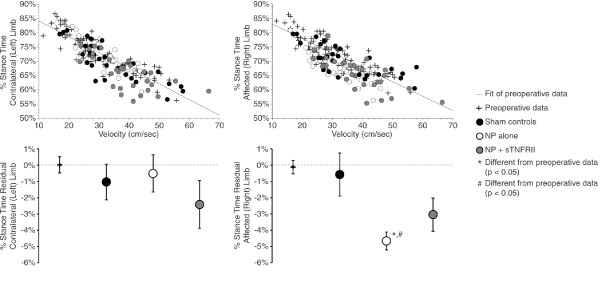
Affected and contralateral percentage stance time in rats with lumbar radiculopathy (five days post-operation). A significant correlation between percentage stance time and velocity is observed in walking rats (upper left and right); raw data with a linear fit of the pre-operative data are shown. As velocity increases, percentage stance time decreases in both the affected (right) and contralateral (left) limb. After accounting for this correlation, decreased affected limb percentage stance times (bottom right), but not contralateral limb stance times (bottom left) can be identified in animals with NP alone relative to pre-operative and sham controls (P = 0.010, P = 0.013, respectively). While sTNFRII treatment improved stance time imbalance resulting from NP application to the L5 DRG (see Figure 1), improvement in the stance time balance in the sTNFRII treated rats appears to result from a relative decrease in both the affected and contralateral limb stance times relative to pre-operative and sham controls.